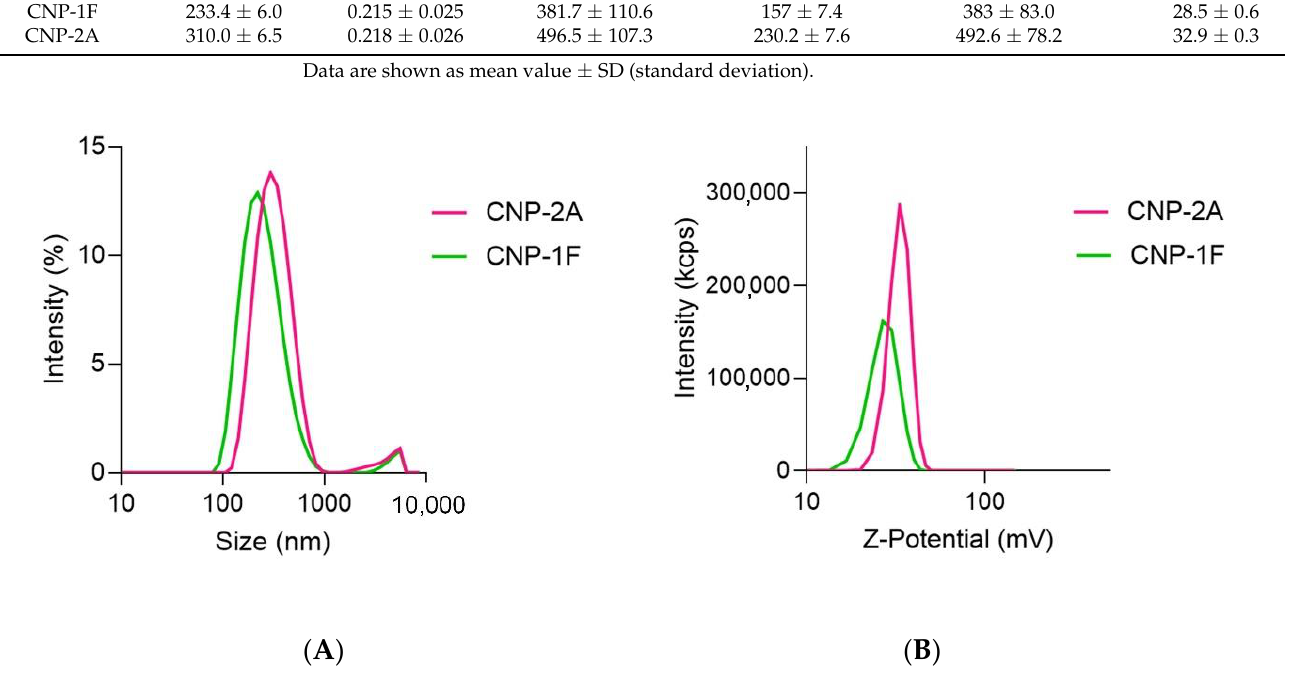
Figure 1. Particle size distribution ( A ) and Z-potential ( B ) of the CNP-2A and CNP-1F. As can be seen in Table 2, when comparing the Z-Average values for samples CNP-1A, CNP-1B, CNP-1C, and CNP-1D, there was a tendency for the hydrodynamic diameter of CNPs to decrease as the volume of antisolvent increased in the range of 50 to 200 mL in the particles in the antisolvent of the viscosity of the solution, the concentration and size of such droplets in the antisolvent. The Z-averages decrease from 537.4 to 274.9 nm. A